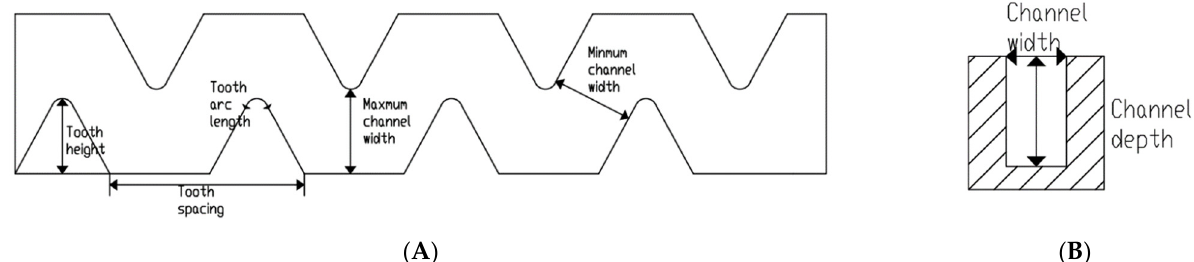
Figure 3. Schematic diagram of the flow channel structure of the inner patch drip irrigation tape. ( A ) Main view of the emitter channel; ( B ) profile view of the emitter channel.